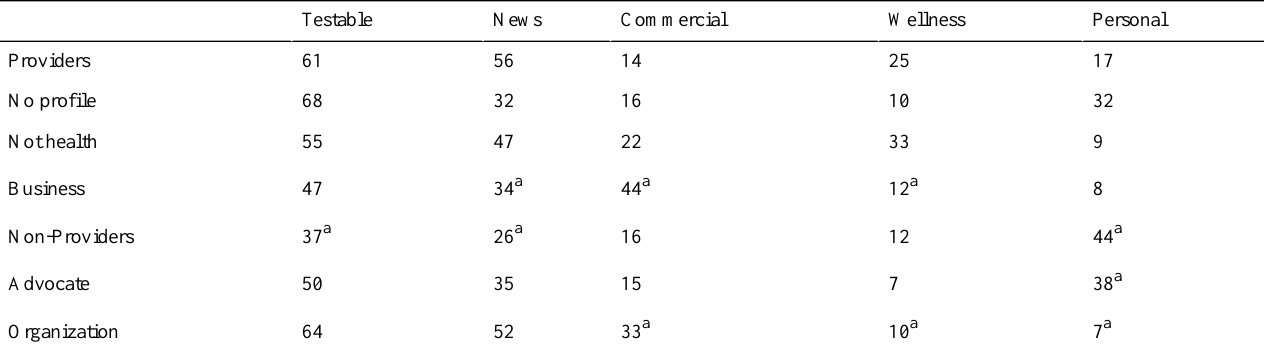
Table 3. Percentage of health-related tweets in selected content areas by user